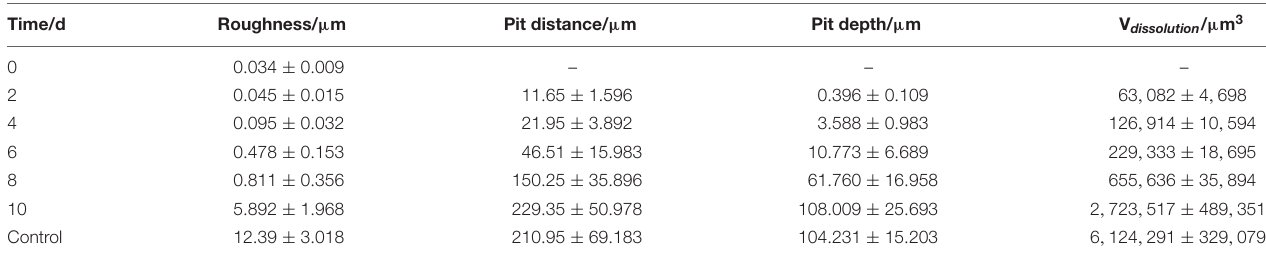
TABLE 1 | Characteristics of arsenopyrite surfaces during bioleaching (pH 1.5, 45 ◦ C with an initial cell density of 1.8 × 10 8